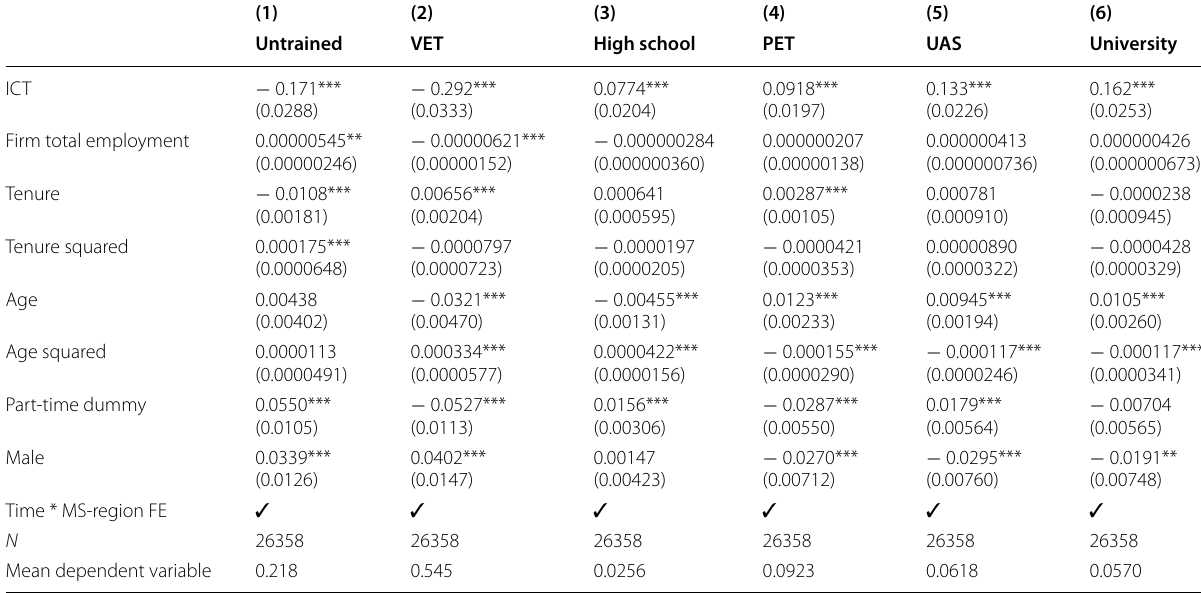
Table 17 Pseudo-panel FE estimation. Cells based on 18 branches instead of two-digit